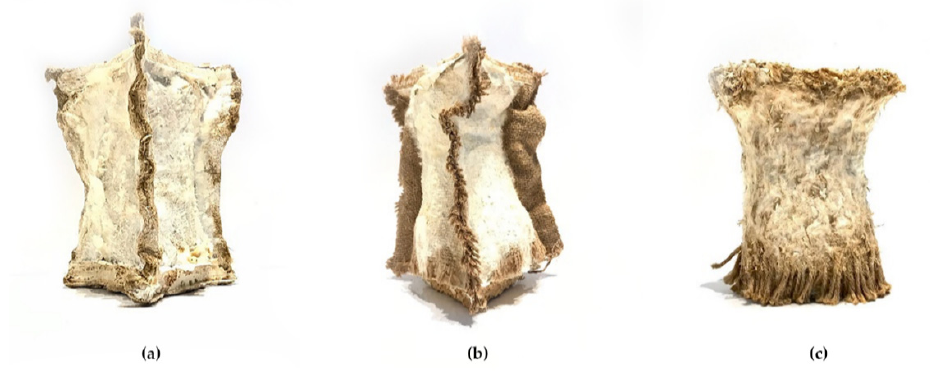
Figure 6. Results of grown on different skin materials: ( a ) hemp sheets, ( b ) jute sheets, ( c ) knitted hemp rope.